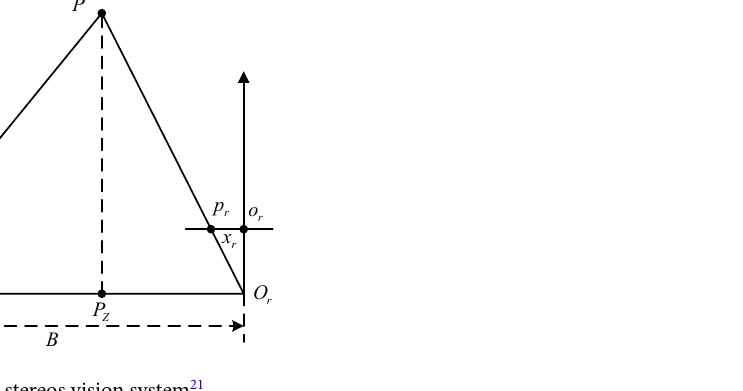
Figure 1. Standard stereos vision system 21